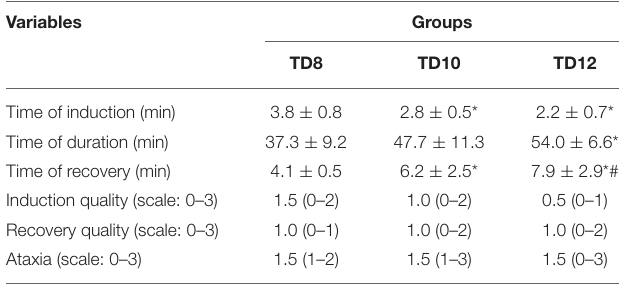
Frontiers in Veterinary Science |